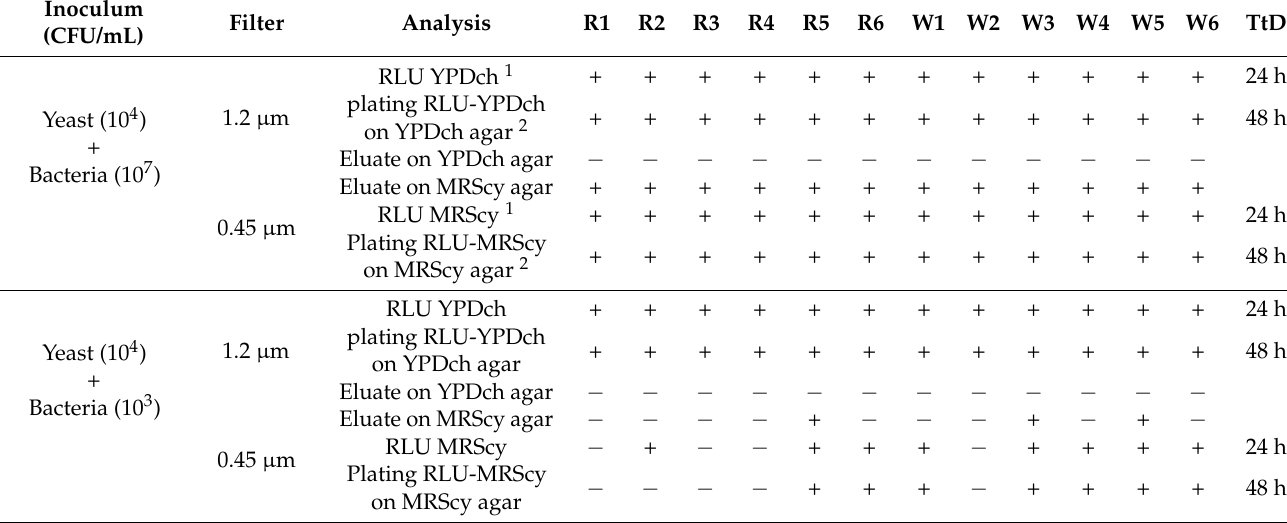
Table 4. Bioluminescence assay (presence/absence) and plating results (presence/absence +/ − ). TtD is the time to detection. Eluates from the first filtration step were plated both on YPDch and MRScy to confirm the filter’s (1.2 µ m) effectiveness in retaining yeasts while being crossed with bacteria.